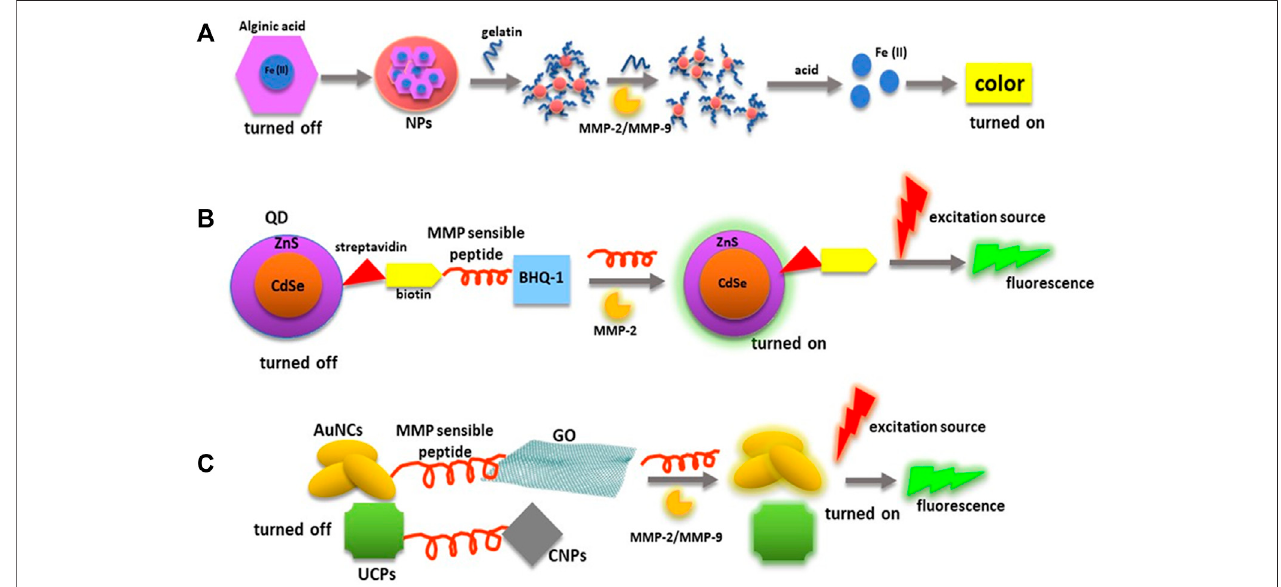
FIGURE 4 | MMPs ’ and diagnostic biosensors. MMPs ’ substrates have been incorporated in nanoprobes to quantify MMPs ’ enzymatic activity. (A) This panel shows a nanocarrier involved in the quanti fi cation of MMPs ’ enzymatic activity through a Fenton ’ s reaction in which gelatin is used as MMP-2/MMP-9 substrate. (B) Peptides degradable by MMPs can be used as a bridge between an energy donor (QDs) and as an energy acceptor (BHQ-1) to turn off fl uorescence emission until the peptide is cleaved by an MMP. (C) MMP cleavable peptides can be directly linked to fl uorescent NPs (AuNCs and UCPs) and NMs employed with quencher functions (GO and AuNCs). Abbreviations: AuNCs, gold nanoclusters; BHQ-1, black hole quencher-1; CNPs, carbon nanoparticles; MMP, matrix metalloproteinase; NMs, nanomaterials; NPs, nanoparticles; QDs, quantum dots; UCPs, upconversion